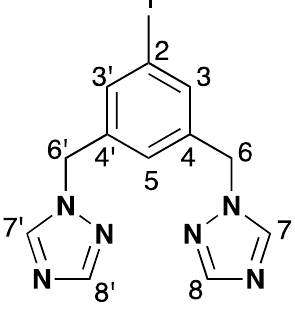
Figure 5. Atom numbering for signal assignment of the NMR for 1.